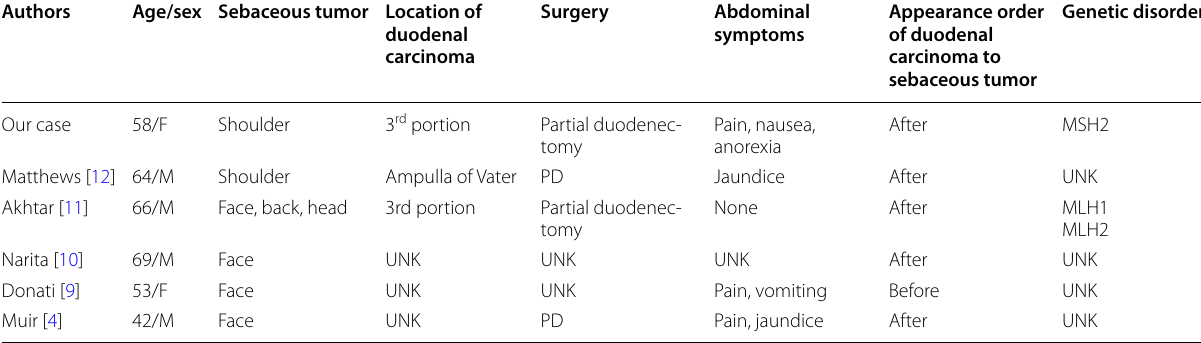
M male, F female, UNK unknown, PD pancreatoduodenectomy